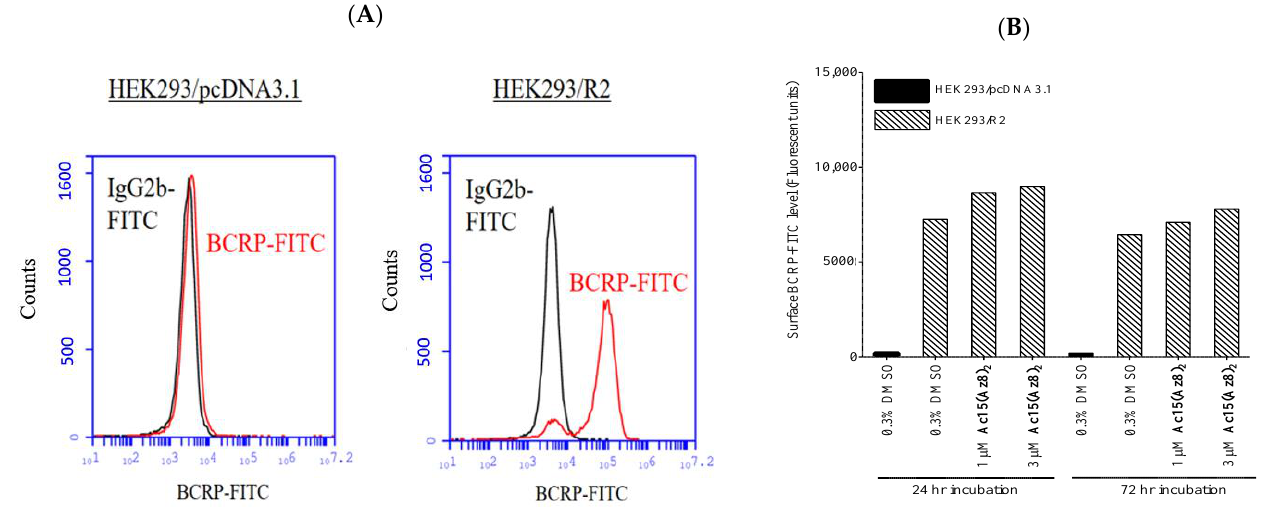
Figure 4. Effect of Ac15(Az8) 2 on surface BCRP protein expression level. ( A ) Cell surface BCRP level of HEK293/pcDNA3.1 and HEK293/R2 cells was measured by flow cytometer using BCRP-FITC antibody. Mouse IgG2b-FITC is an isotype control. ( B ) The surface BCRP level of HEK293/R2 cells was detected after incubating with 1 or 3 µ M of Ac15(Az8) 2 for 24 h or 72 h, respectively; 0.3% of DMSO was used as solvent